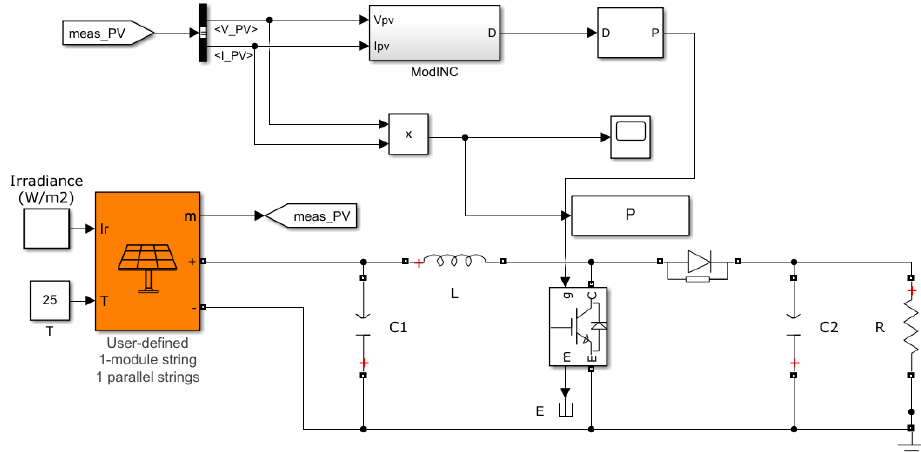
Figure 15. Improved Simulation Model of Three-Stage Variable Step Incremental Conductance Method. Table 3. PV Module and Circuit Parameters.